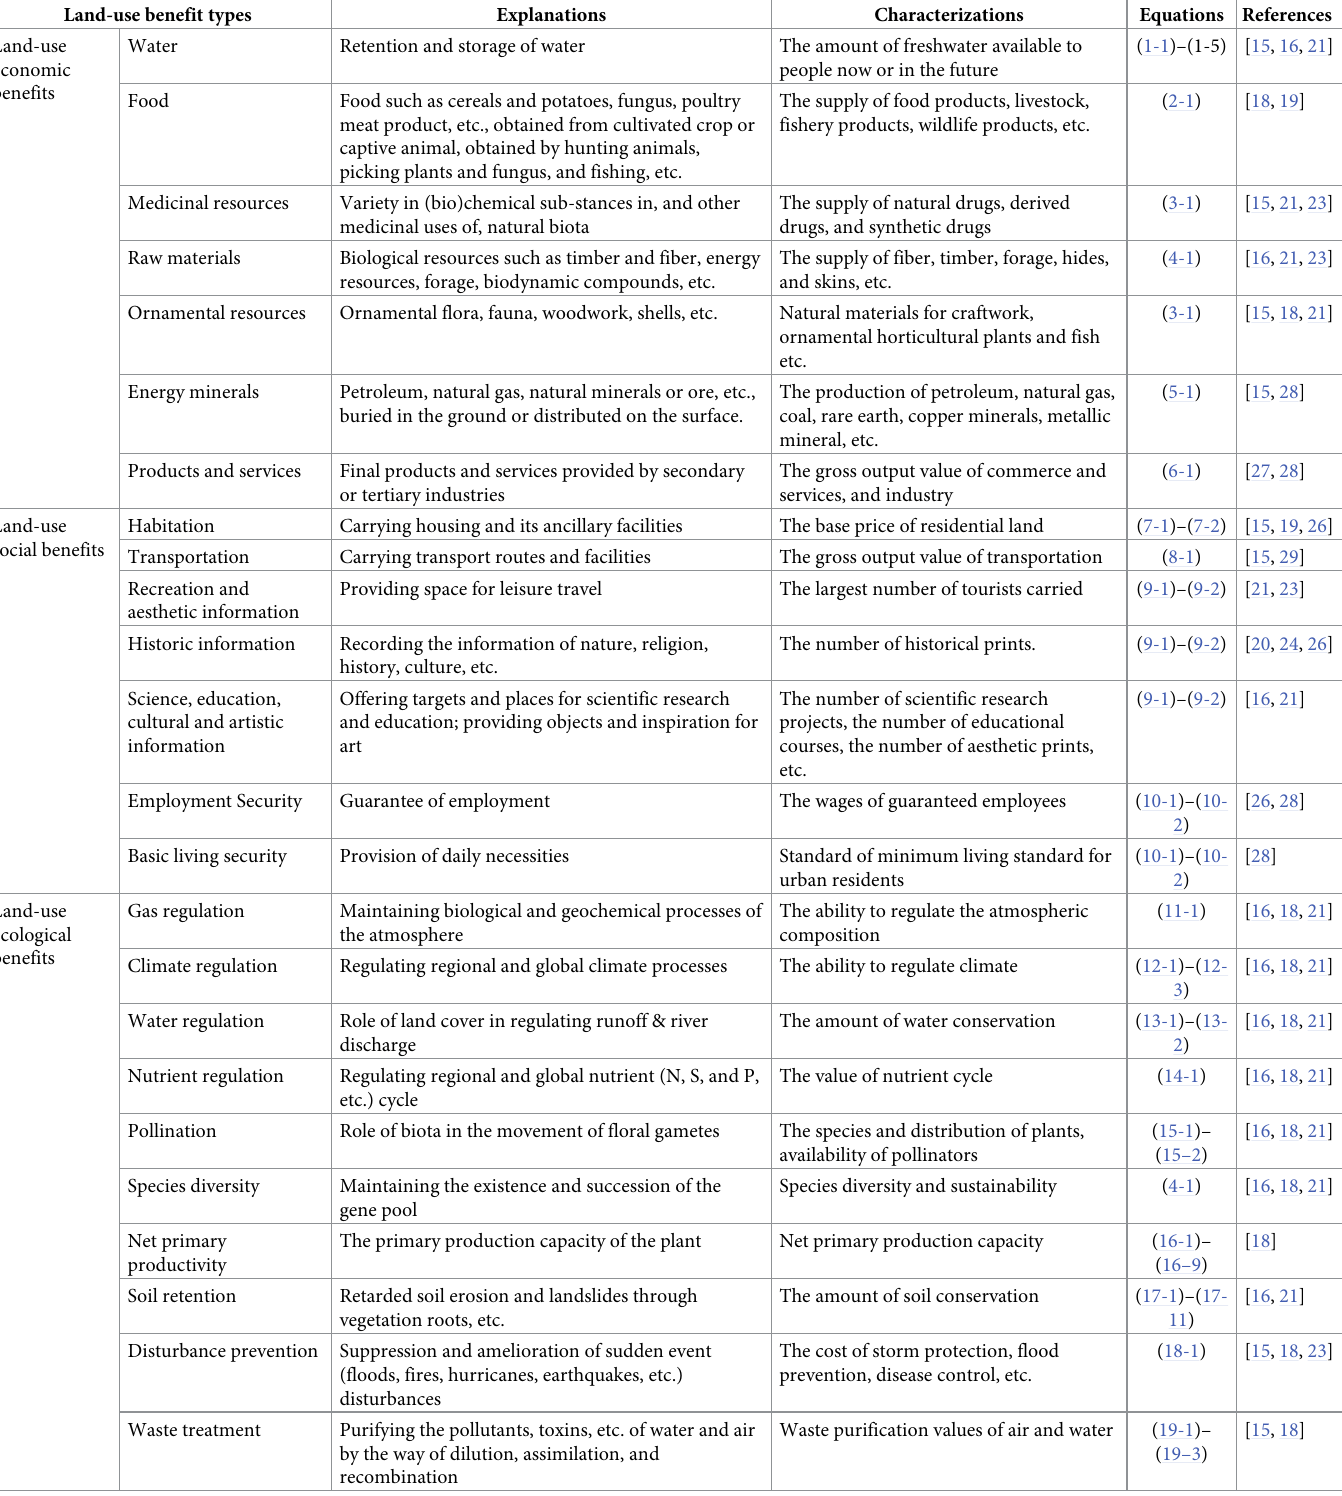
Table 1. Land-use benefit classification